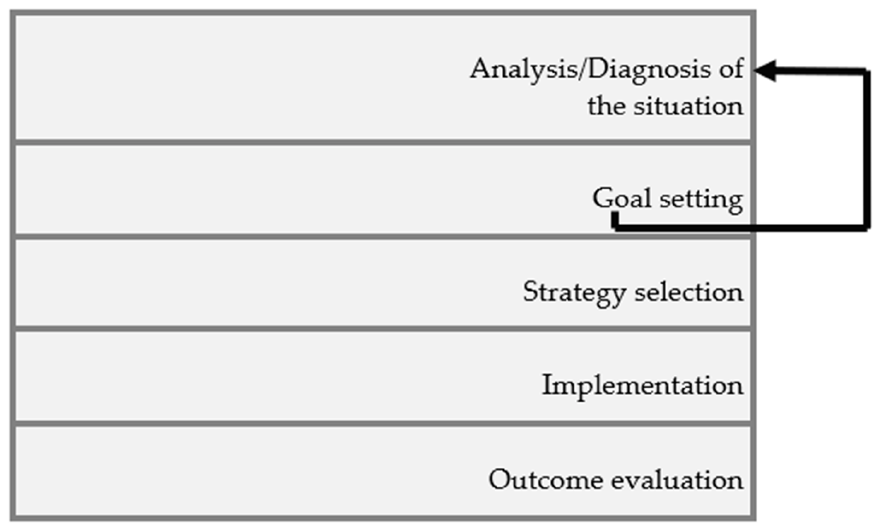
Figure 2. Phases of the process for planning the care delivery work method.